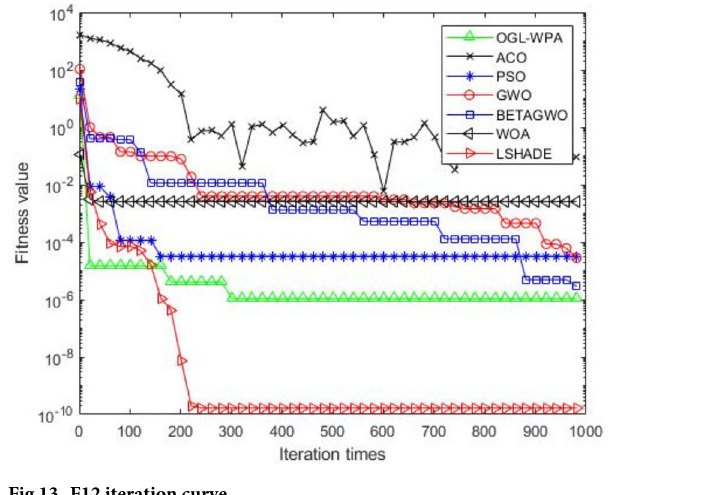
Fig 13. F12 iteration